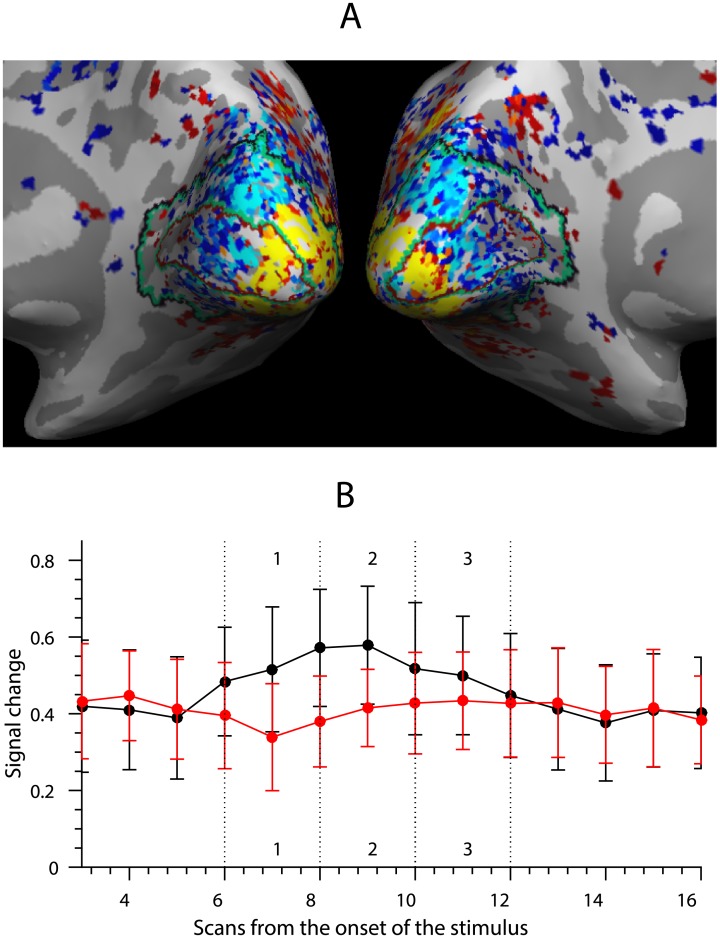
Interference between task phases: Retinotopic suppression.(A) Activation and suppression in V1 averaged across all stimuli for a single participant. The activated voxels (yellow, p < 0.001) mark the foveal part of the visual cortex driven by the stimuli (presented at 6° visual angle). (B) Peristimulus time histogram of sequence presentation of two groups of voxels from a single participant’s V1. The black line denotes the average of the voxels activated by the stimuli and the red line denotes the average of the voxels suppressed by the stimuli. Dashed vertical lines indicate the time bins where sequence items were presented.